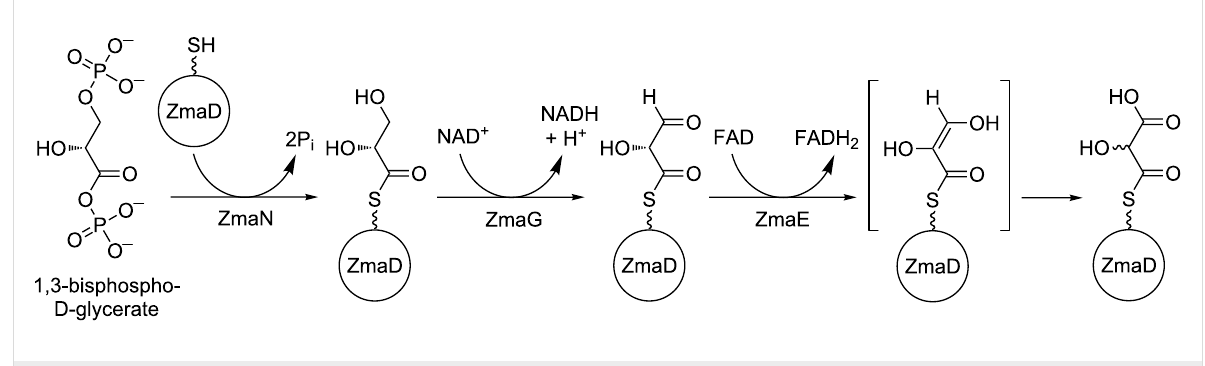
Figure 6: Biosynthetic pathway of hydroxymalonyl-ACP. Adapted from [24].